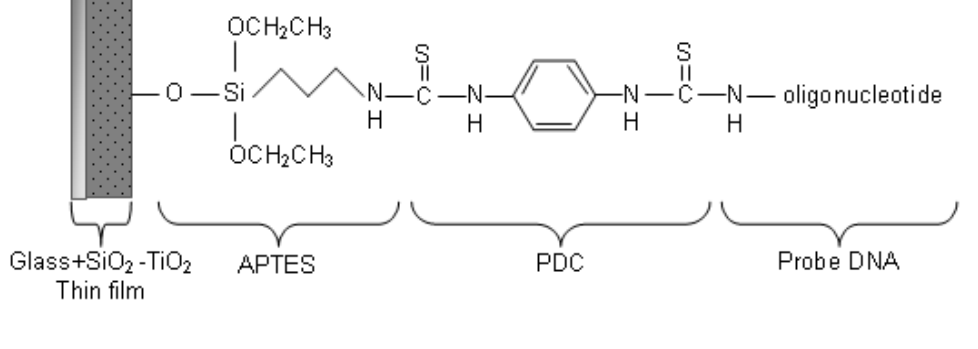
Figure 6. The proposed surface structure after probe DNA immobilization.